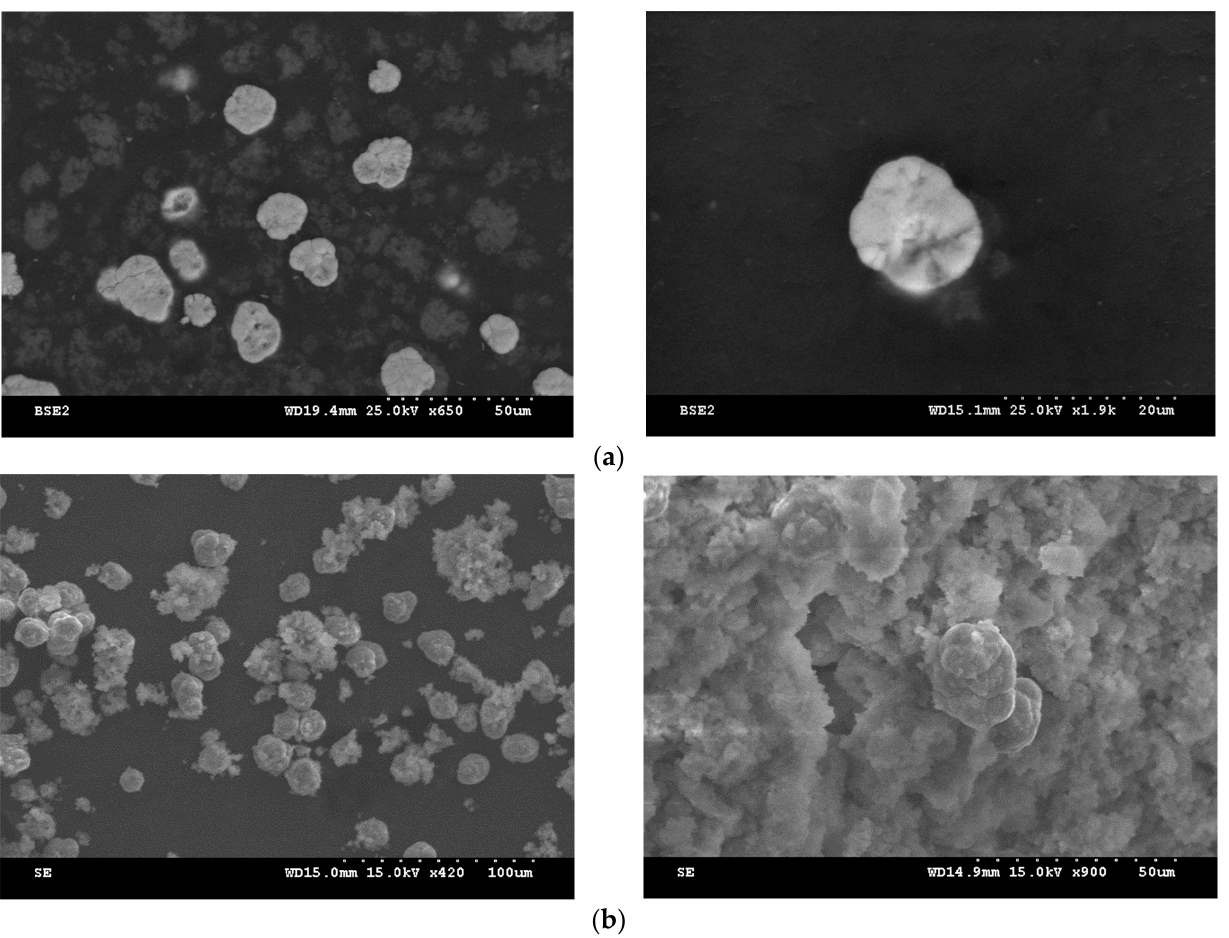
Figure 5. SEM cross-section images of resulting scorodite@HAP solids from ( a ) ENCH-A 60 mmol/L P and 100 mmol/L Ca, 9 nucleation steps. Growth in 1 step of 20 mL/h, 22 °C for 7 h and ( b ) 9 nucleation steps and growth at 37 °C and pH 7.4 for 6 h.